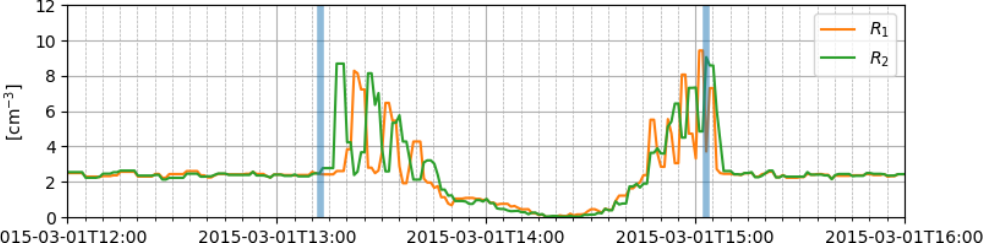
Figure 3. The proton number density along the MEX orbit for the two best fit simulation runs ( R 1 in orange and R 2 in green), at 490s of simulation time. The blue vertical lines show the two bow shock crossings seen in MEX electron